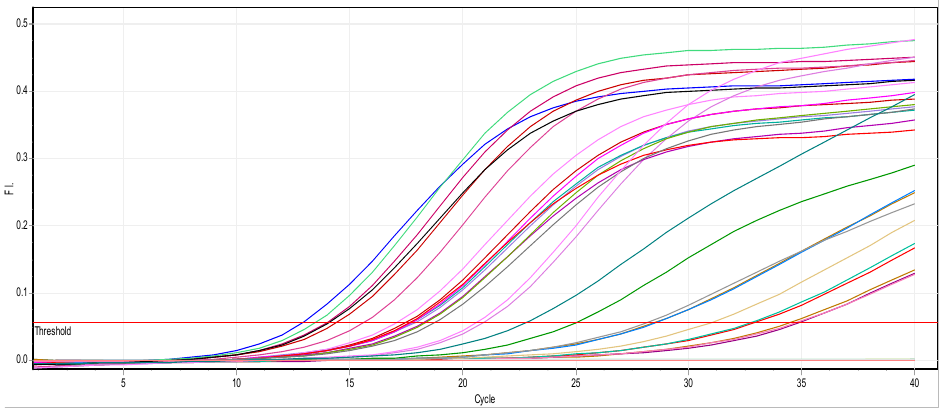
Figure 4. Real-time PCR results of the k2A gene.